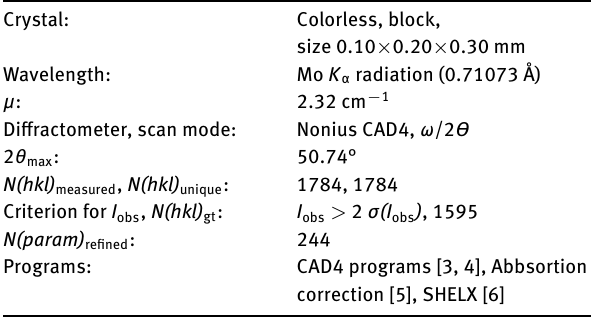
Table 1: Data collection and